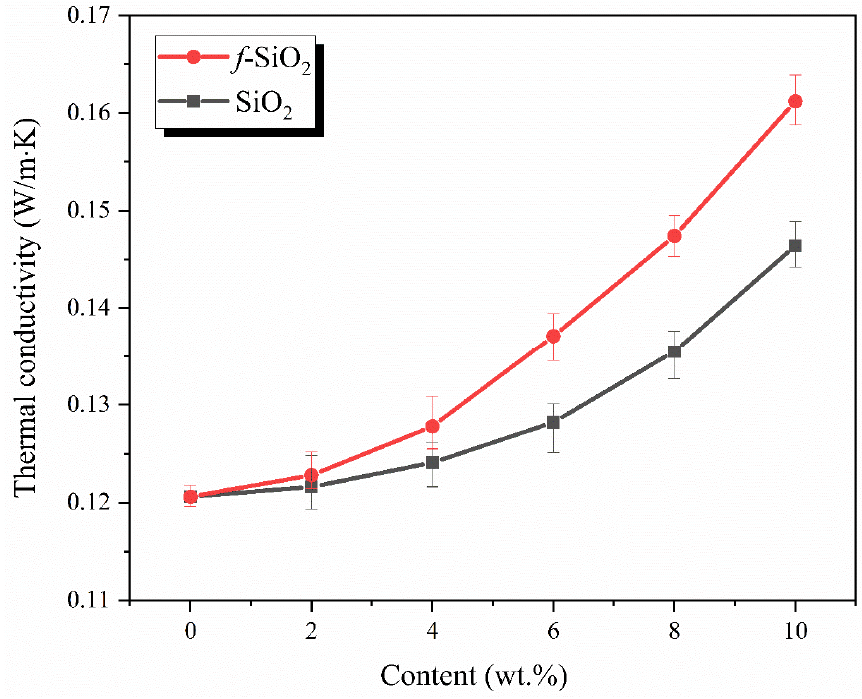
Figure 8. Thermal conductivity of f -SiO 2 /SR and SiO 2 /SR composites with different fillers loadings.